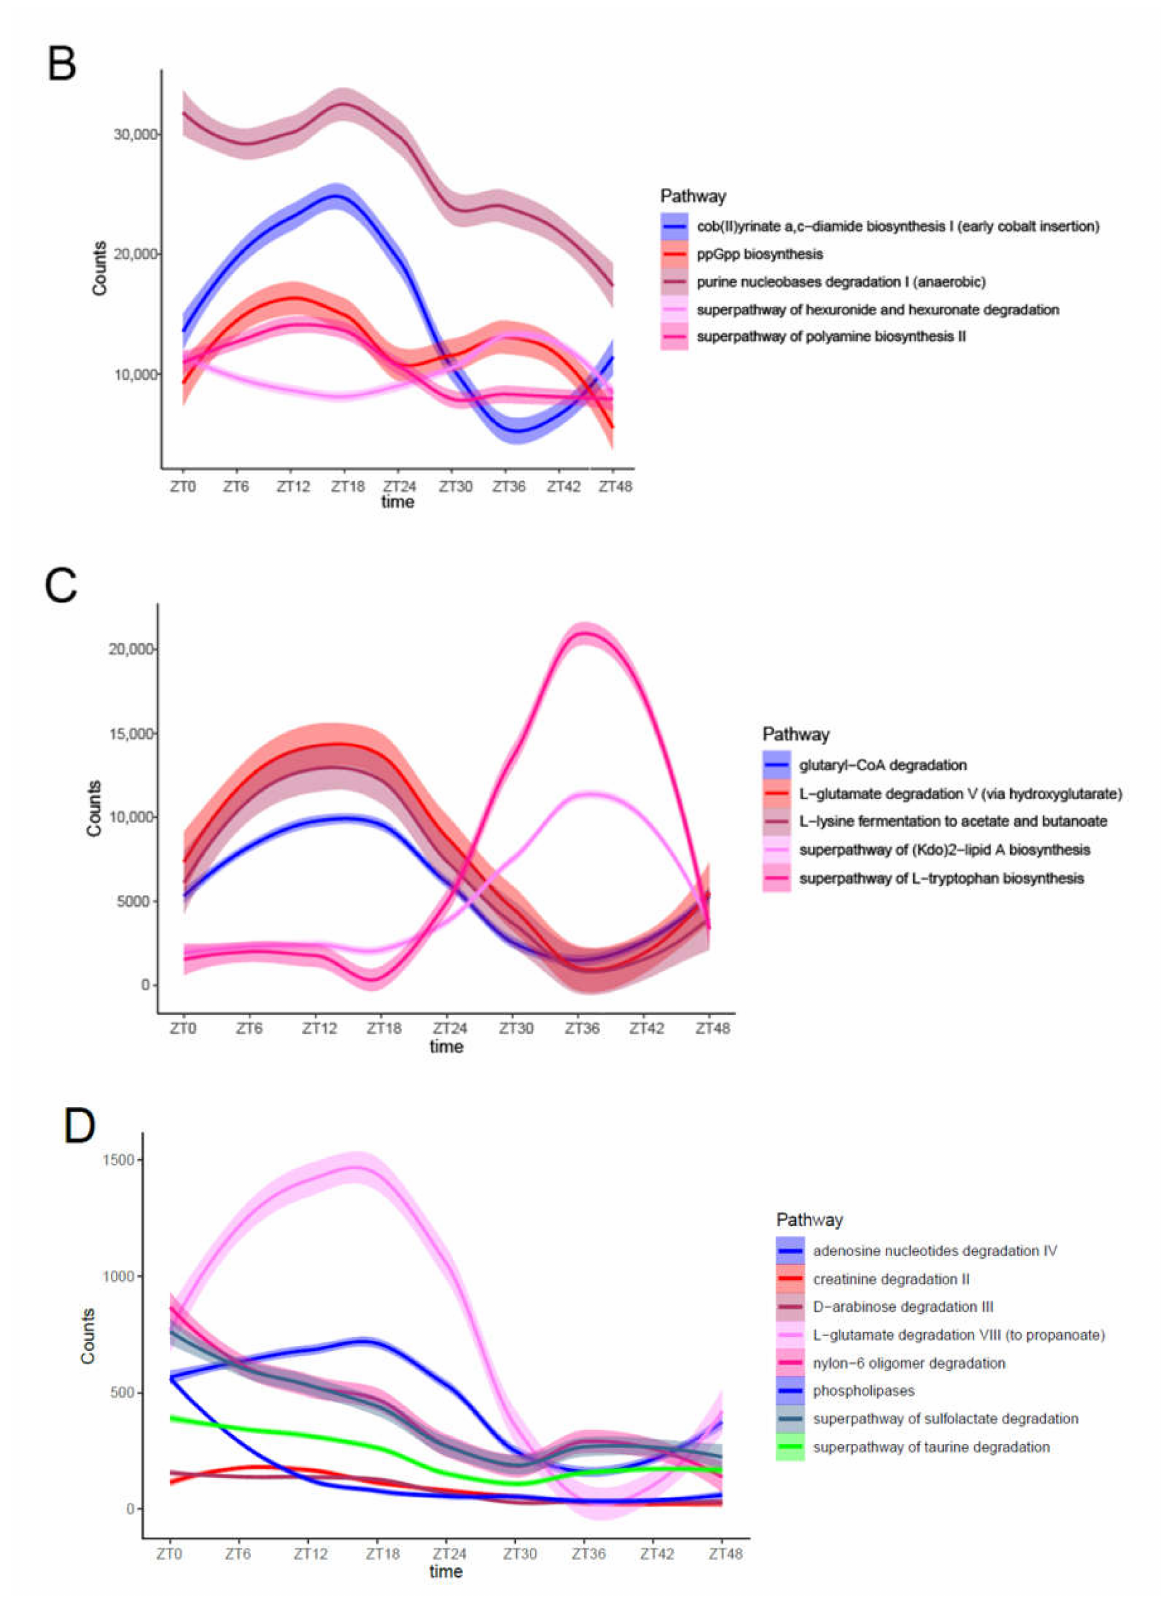
Figure 6. The important bacterial functions were identified by random forest analysis. ( A ) Tracing the source of the top 30 most important bacterial functions in the fecal microbiota; ( B – D ) The temporal changes in the contributing bacterial